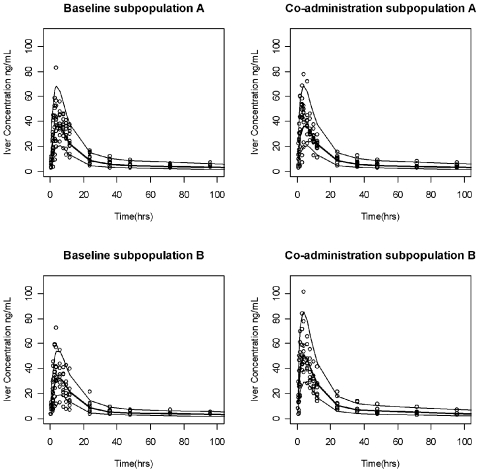
Observed data plotted as individual points.The solid center lines represent the median values of the 1000 simulated data sets, whereas the upper and lower lines represent the 97.5th and 2.5th quantiles of the simulated data, respectively.